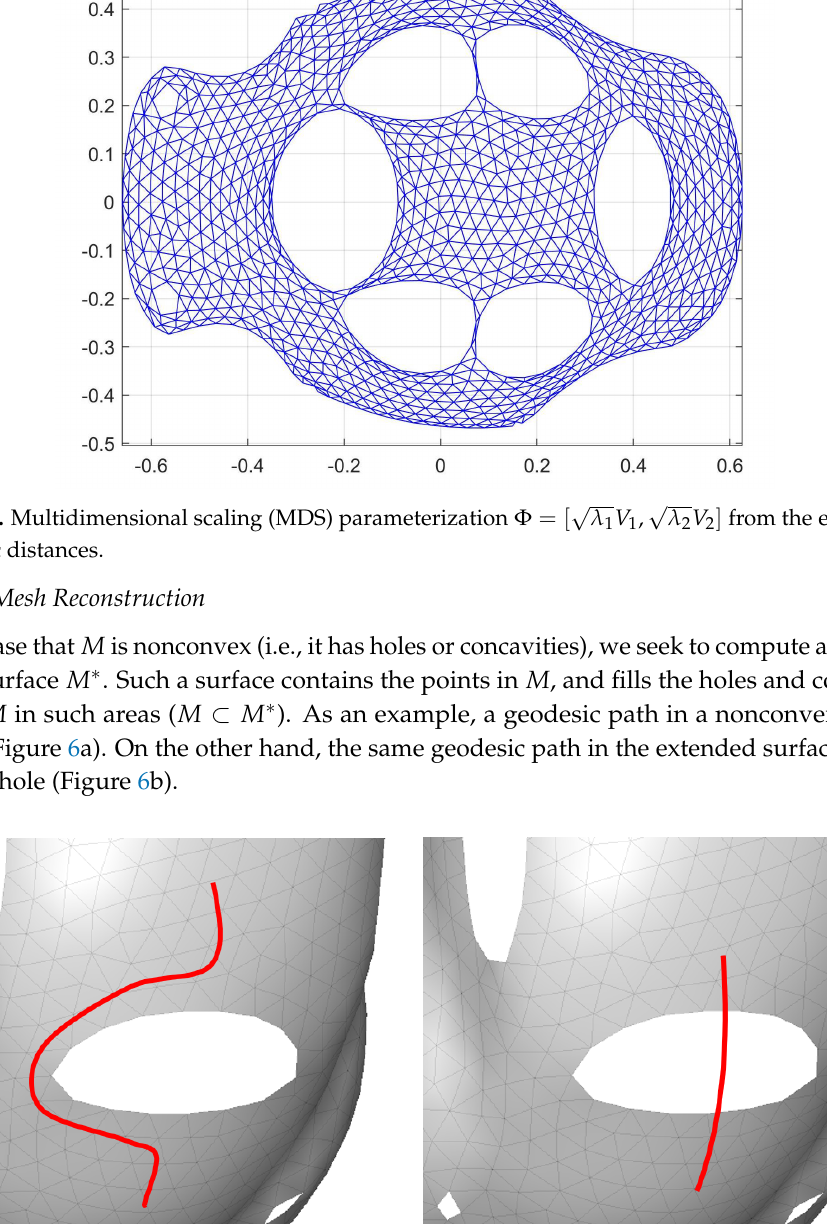
Figure 6. Our algorithm computes an underlying Poisson surface M ∗ to fix the geodesic paths on nonconvex mesh M . ( a ) Geodesic path on raw mesh M . ( b ) Geodesic path on M with the help of underlying Poisson